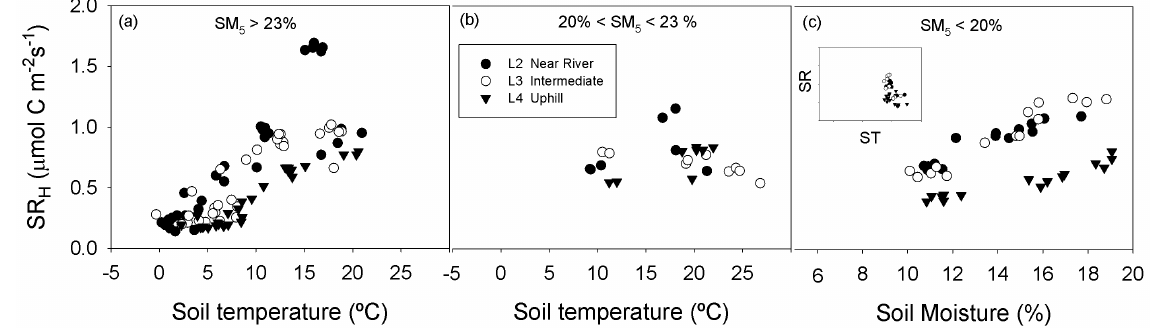
Figure 4. Differentiation of soil temperature (ST) and soil moisture (SM) as primary controlling factors for SR H . At SM 5 ≥ 23%, there are positive correlations of SR H with soil temperature in all levels (a) . At 20% ≤ SM 5 < 23%, there is a transition with no clear relationship of either SM or ST with SR H (b) . At SM 5 < 20%, there is no relationship between SR and ST as the inset figure shows (c) ; it switches from ST to SM 5 as the controlling factor with positive correlations between SR H and SM 5 for all levels. Campaigns with SM 5 < 20% were all from spring and summer 2012. SM 5 (5cm integral soil moisture).